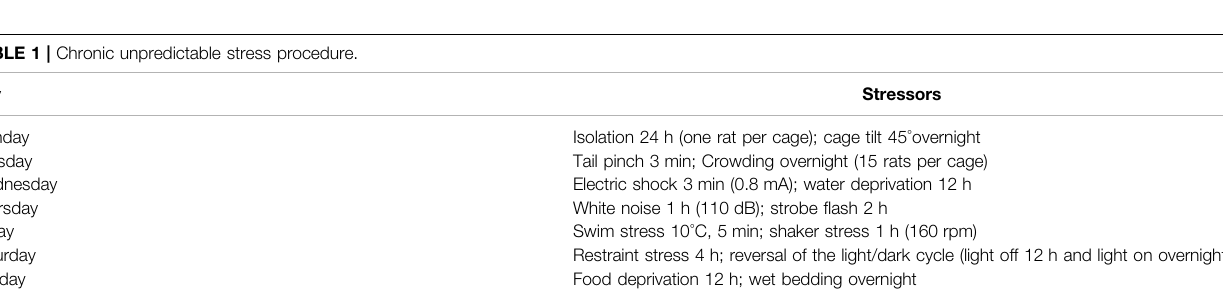
TABLE 1 | Chronic unpredictable stress